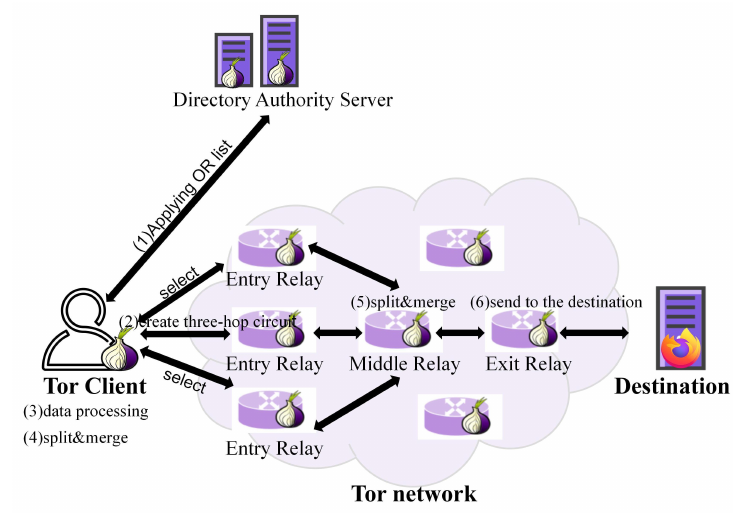
Figure 2. Multi-path defense